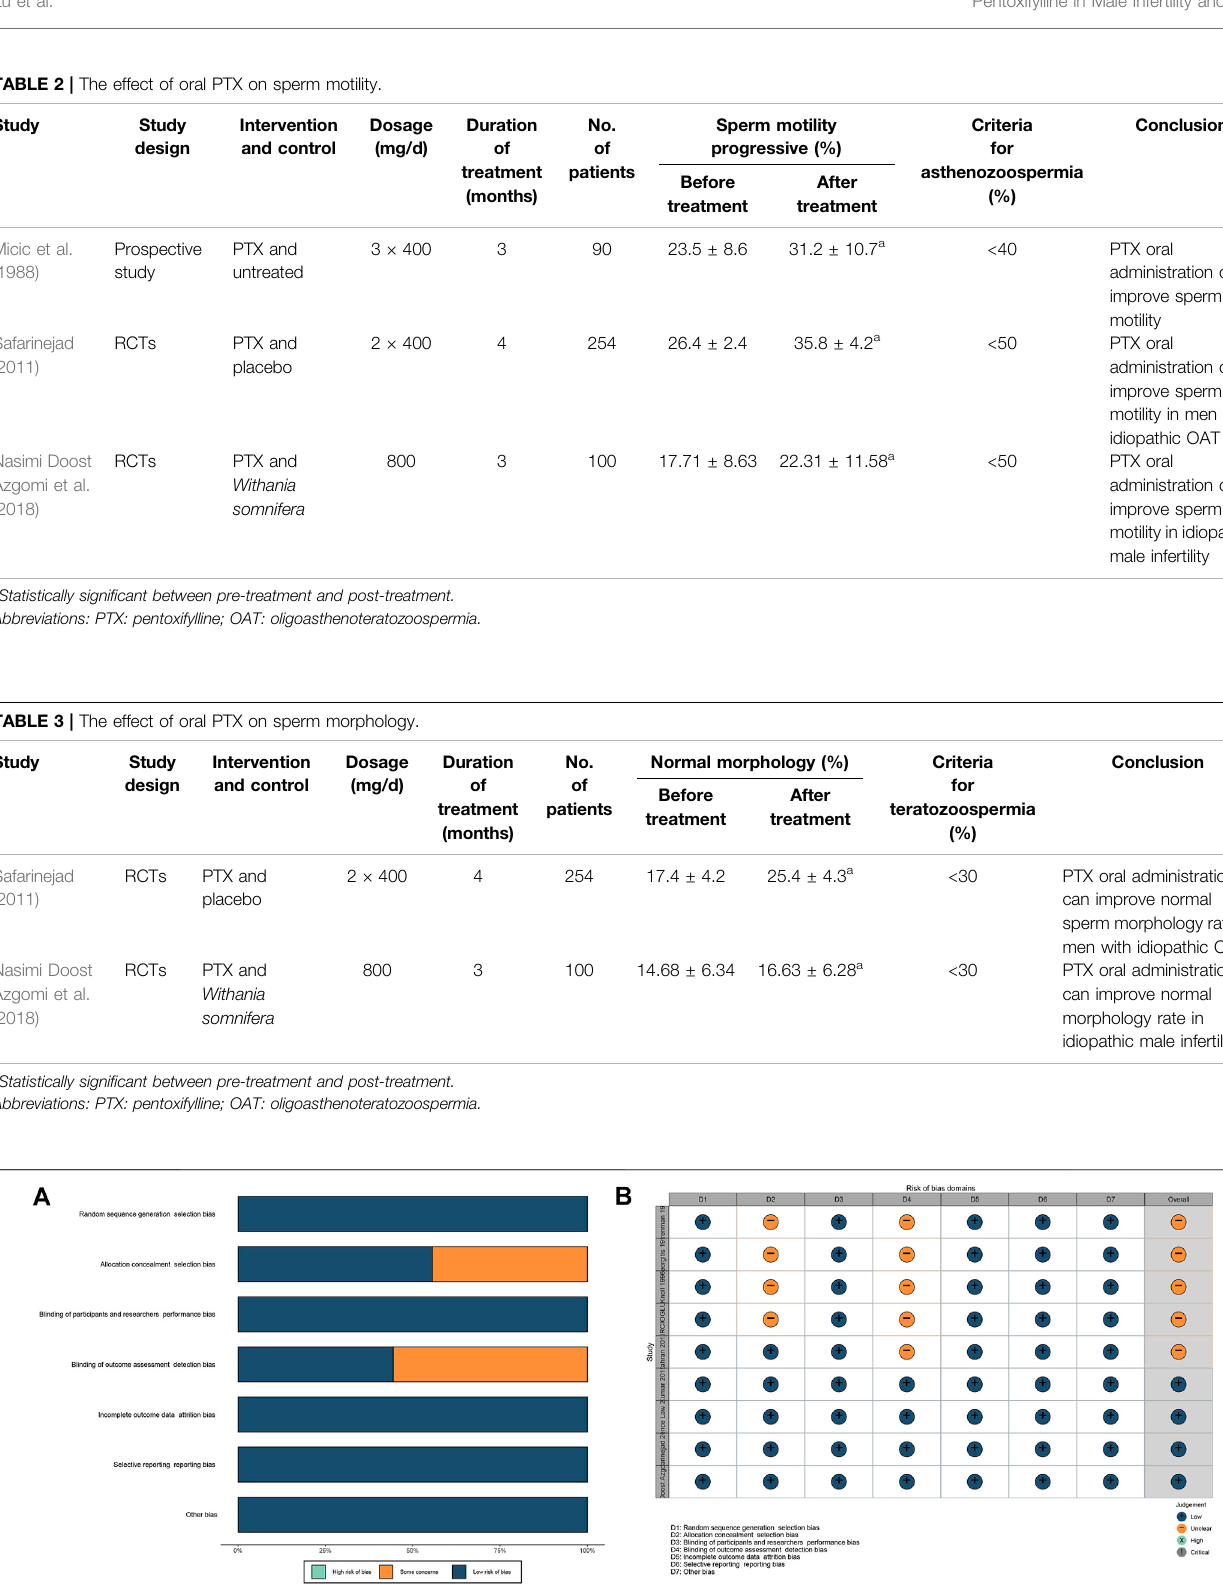
Frontiers in Pharmacology |